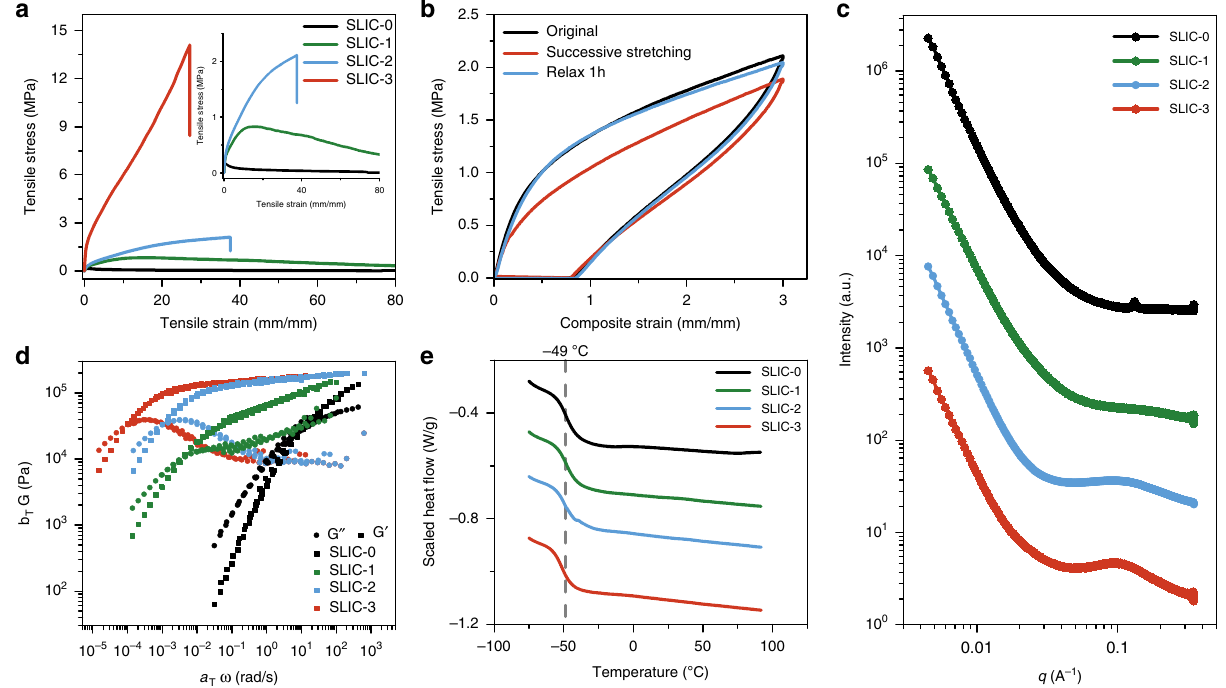
Fig. 2 Characterization of SLIC macromolecules. a Stress-strain curves of SLIC-0 to SLIC-3 at an extension rate of 100 mm min − 1 . Inset: zoom in of low- stress region of the stress-strain curve. b Strain cycling of SLIC-3 at a rate of 30 mm min − 1 . SLIC-3 is stretched to 300%, and then stretched again immediately. After relaxing 1 h, the third stretch is performed. c SAXS of SLICs. d Time-temperature superposition rheology of SLIC-0 to SLIC-3. e DSC Traces of SLICs. The constant T g at around − 49 °C is